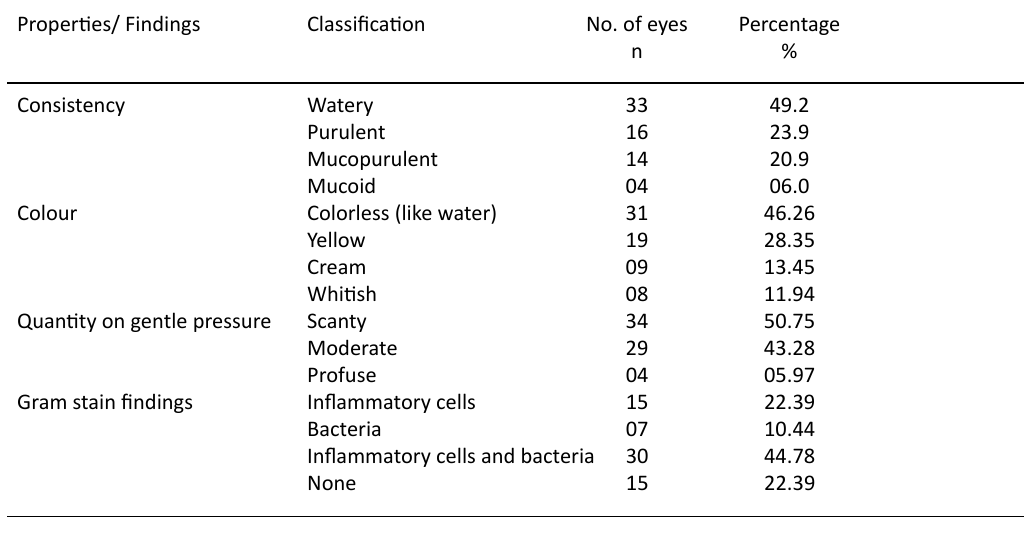
Table 3. Distribution of clinical samples according to consistency, color, quantity, and Gram stain findings of discharge (n = 67) Properties/